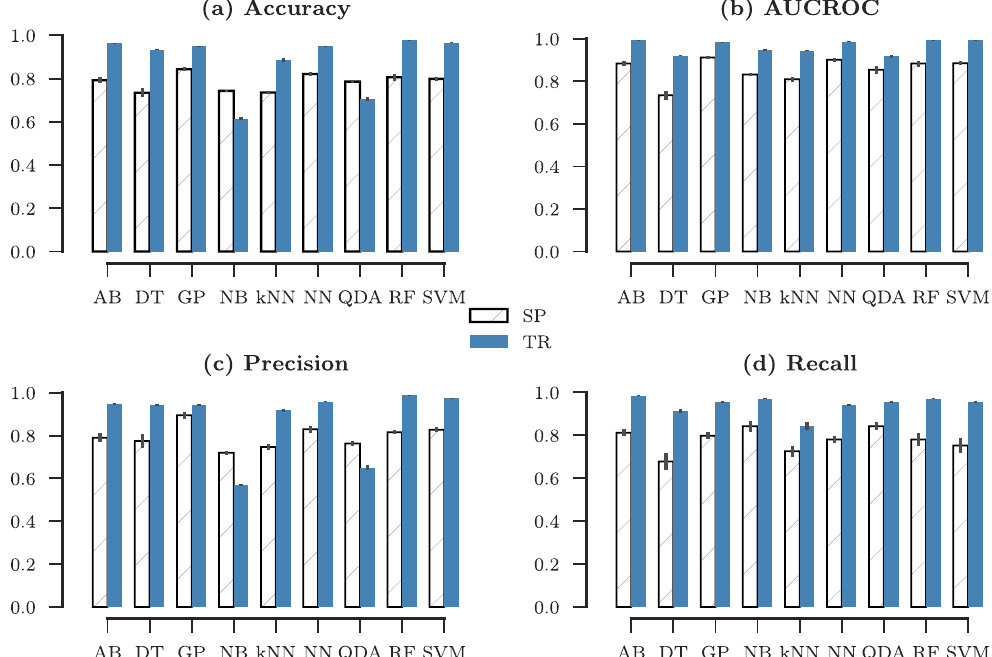
Figure 2. Learning performance. The classification ( a ) accuracy, ( b ) area-under-receiver-operating- characteristic-curve (AUCROC), ( c ) precision, and ( d ) recall scores (mean of 10-fold CV) for the different supervised learning methods applied to the SP (white hatched) and the TR (gray) feature sets. The errorbars represent the standard deviation of the cross validation. We observe that the classification accuracy is significantly better for the TR feature sets, expect for in the cases of Näive Bayes’, and quadratic discriminant analysis. The dark bars represent the TR feature set, while the hatched bars represent the SP